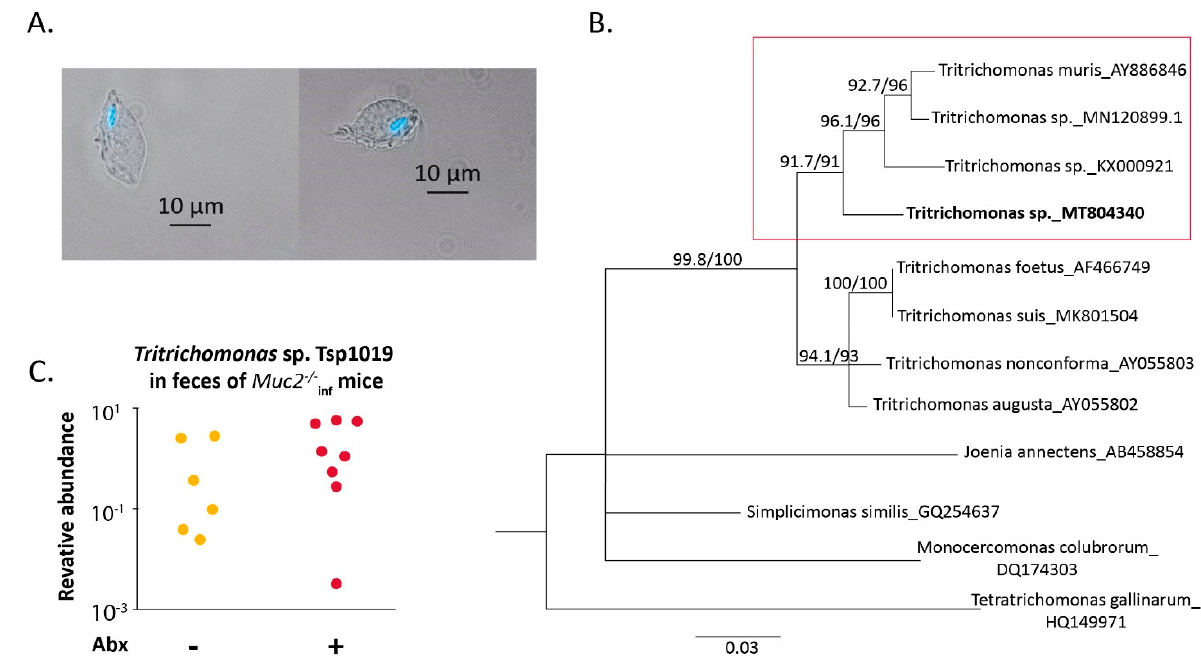
Figure 2. Protozoan microorganism Tritrichomonas sp. clone Tsp1019 was detected in the intestine of Muc2 − / − mice. ( A ) Micrograph demonstrates microorganism purified from cecal content stained with Hoechst 33258 (magnification × 400), the bright field and Hoechst 33258 are merged. Scale bar = 10 µ m. ( B ) Phylogenetic analysis of 18S rRNA DNA sequence obtained from gut content of Muc2 − / − mice. ( C ) Relative abundance of Tritrichomonas sp. Tsp1019 DNA in feces of Muc2 − / − mice on the day 15, normalized on Mus musculus 28S rRNA DNA.